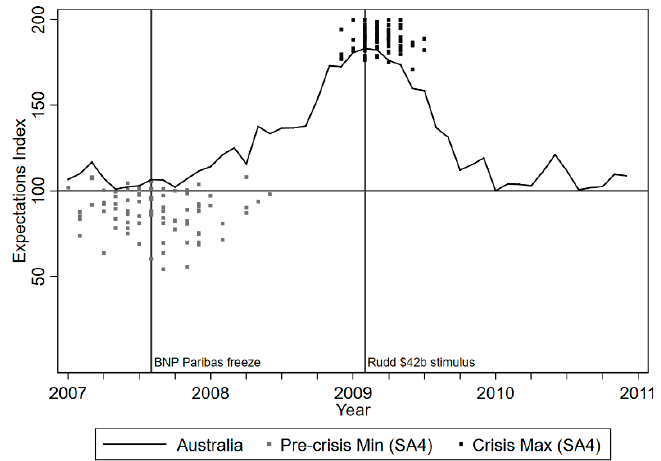
Figure 1. National and community-level unemployment expectations index (UEI) from 2007 to 2011.